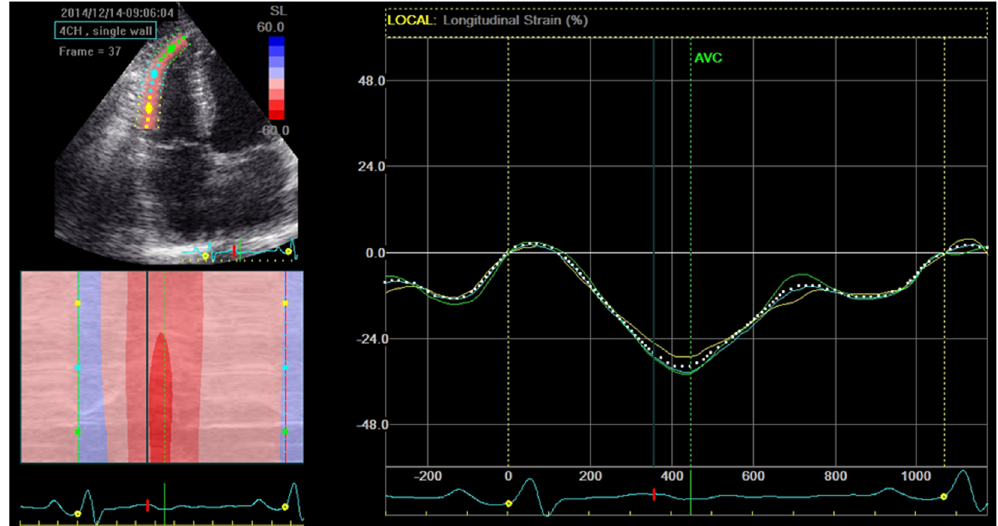
Figure 1. RV longitudinal strain curve by 2D STE. RV, right ventricle; 2D STE, two-dimensional speckle- tracking